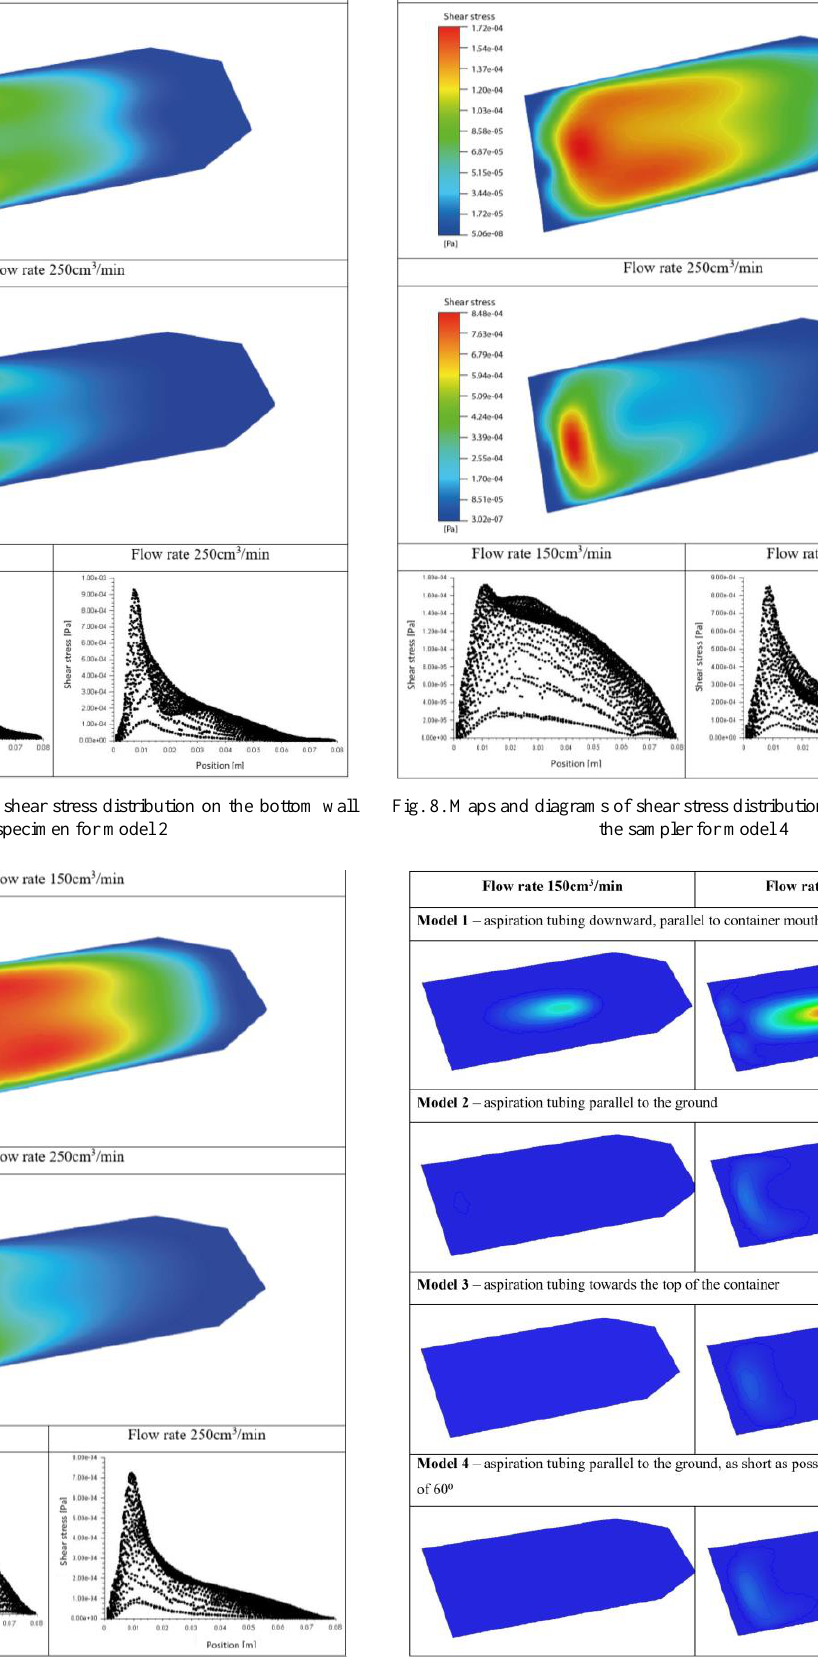
Fig. 9. Comparison of shear stress distributions on the lower wall of the sampler for individual